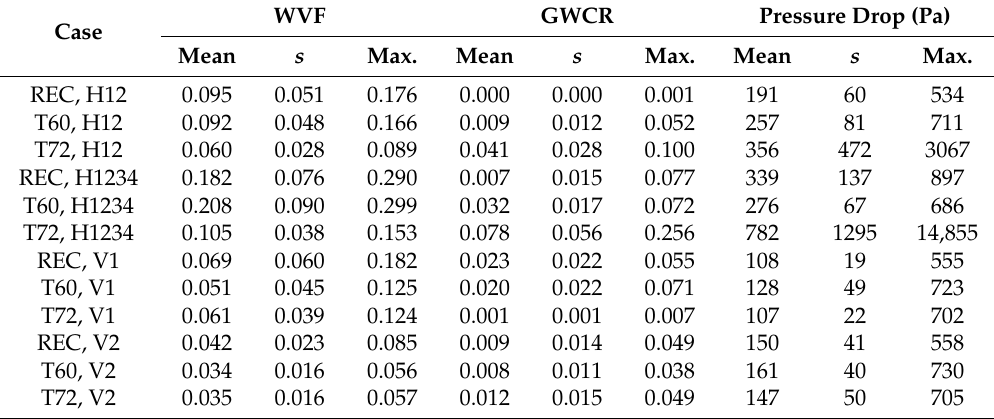
Table 3. Mean, standard deviation ( s ), and maximum values of WVF, GWCR, and pressure drop